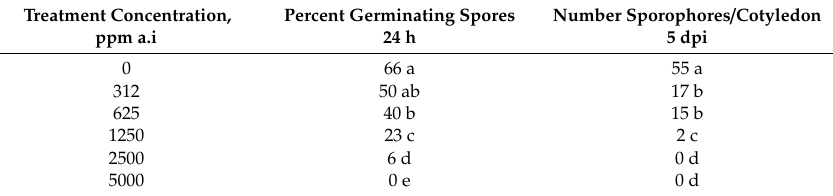
Table 5. The e ff ect of Timorex Gold on conidial germination at 24 h and sporophore formation at 5 dpi of B. lactucae on detached cotyledons of lettuce a .